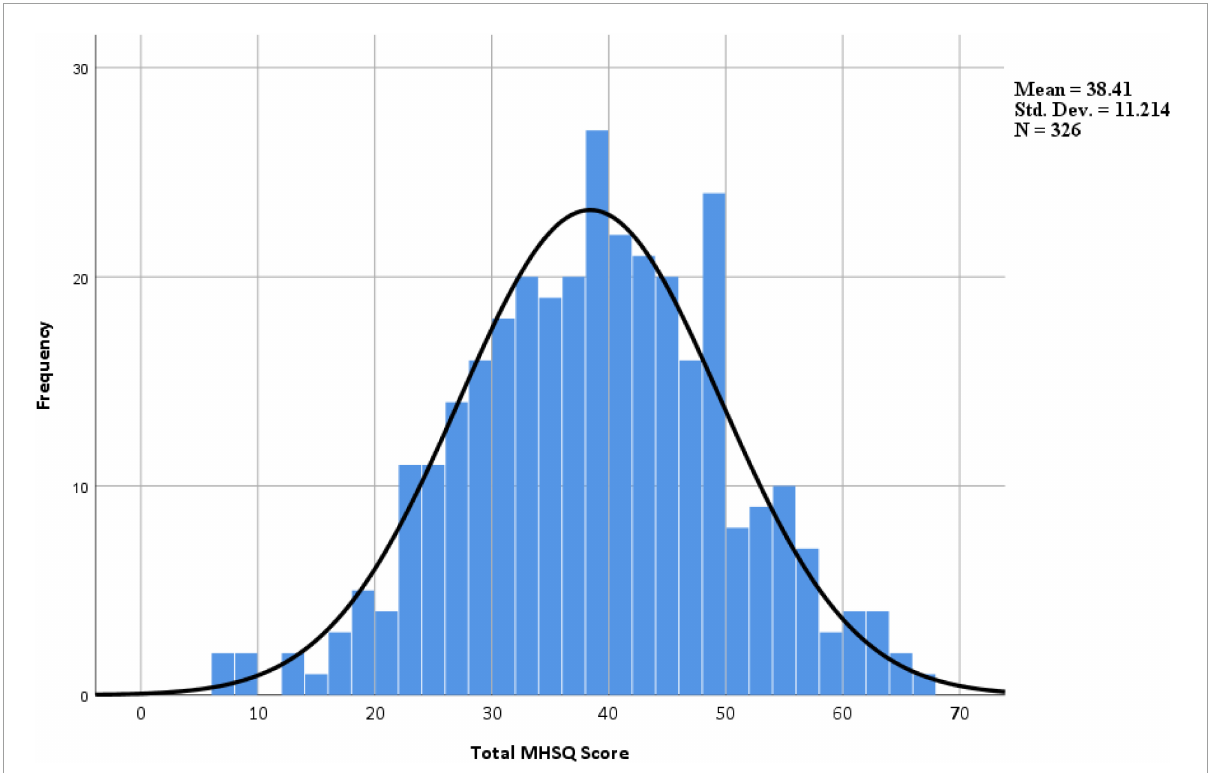
FIGURE2 Histogram of the MHSQ score. MHSQ, Mental Health Self-management